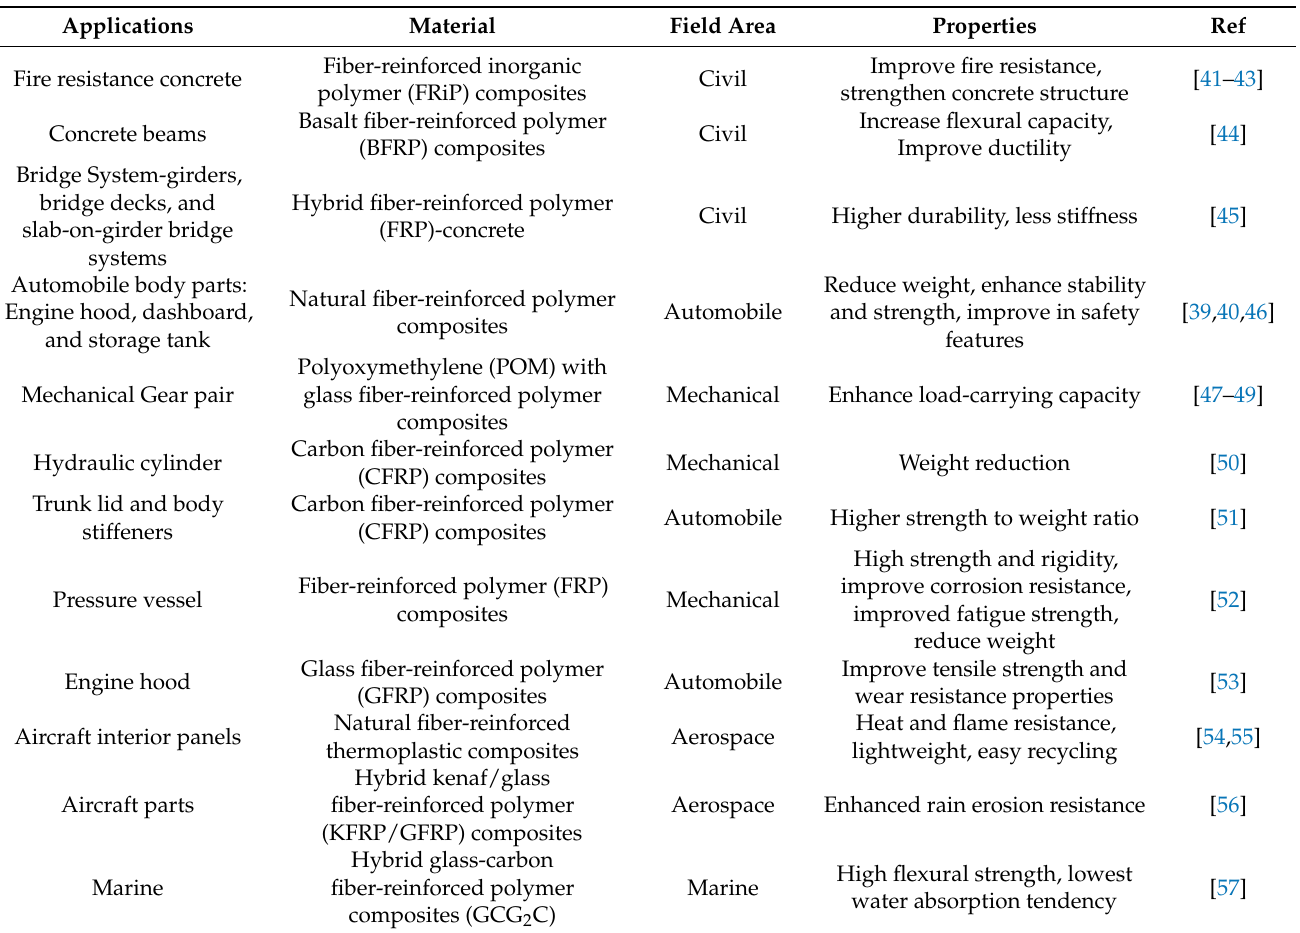
Table 1. Applications of fiber-reinforced polymer composite